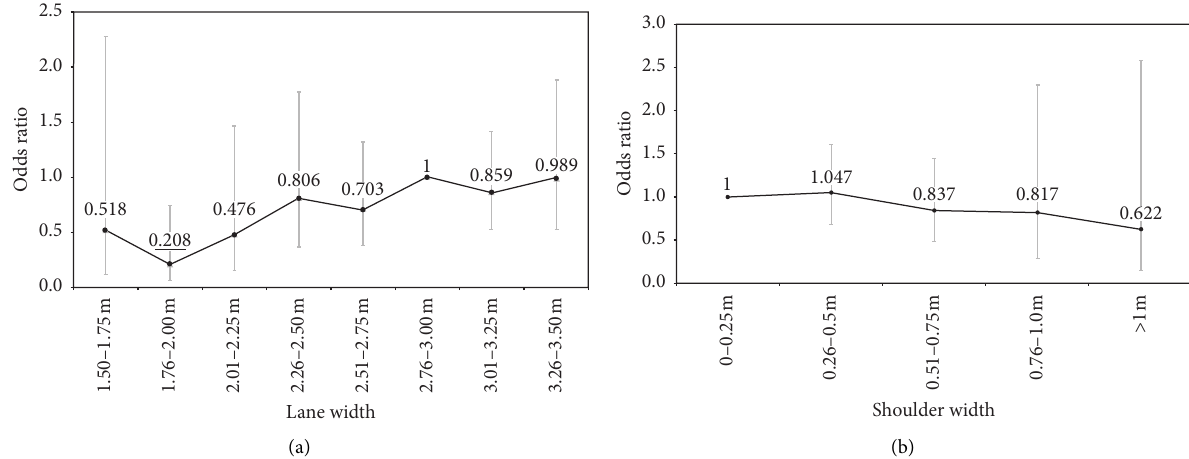
Figure 2: Odds ratio for (a) lane width and (b) shoulder width and 95% confidence intervals. Significant ( p < 0 . 05) result is